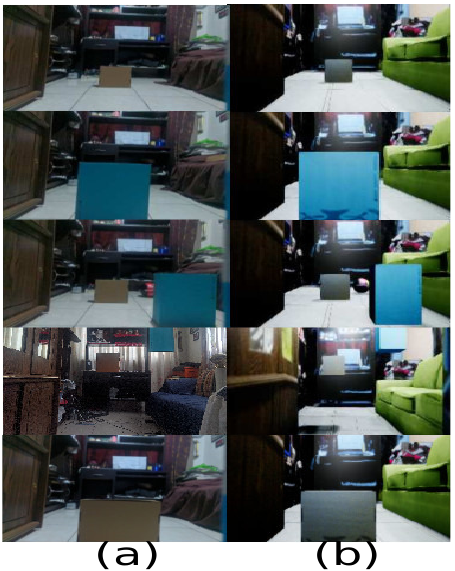
Figure 17. Trained samples. ( a ) Real samples; ( b ) virtual